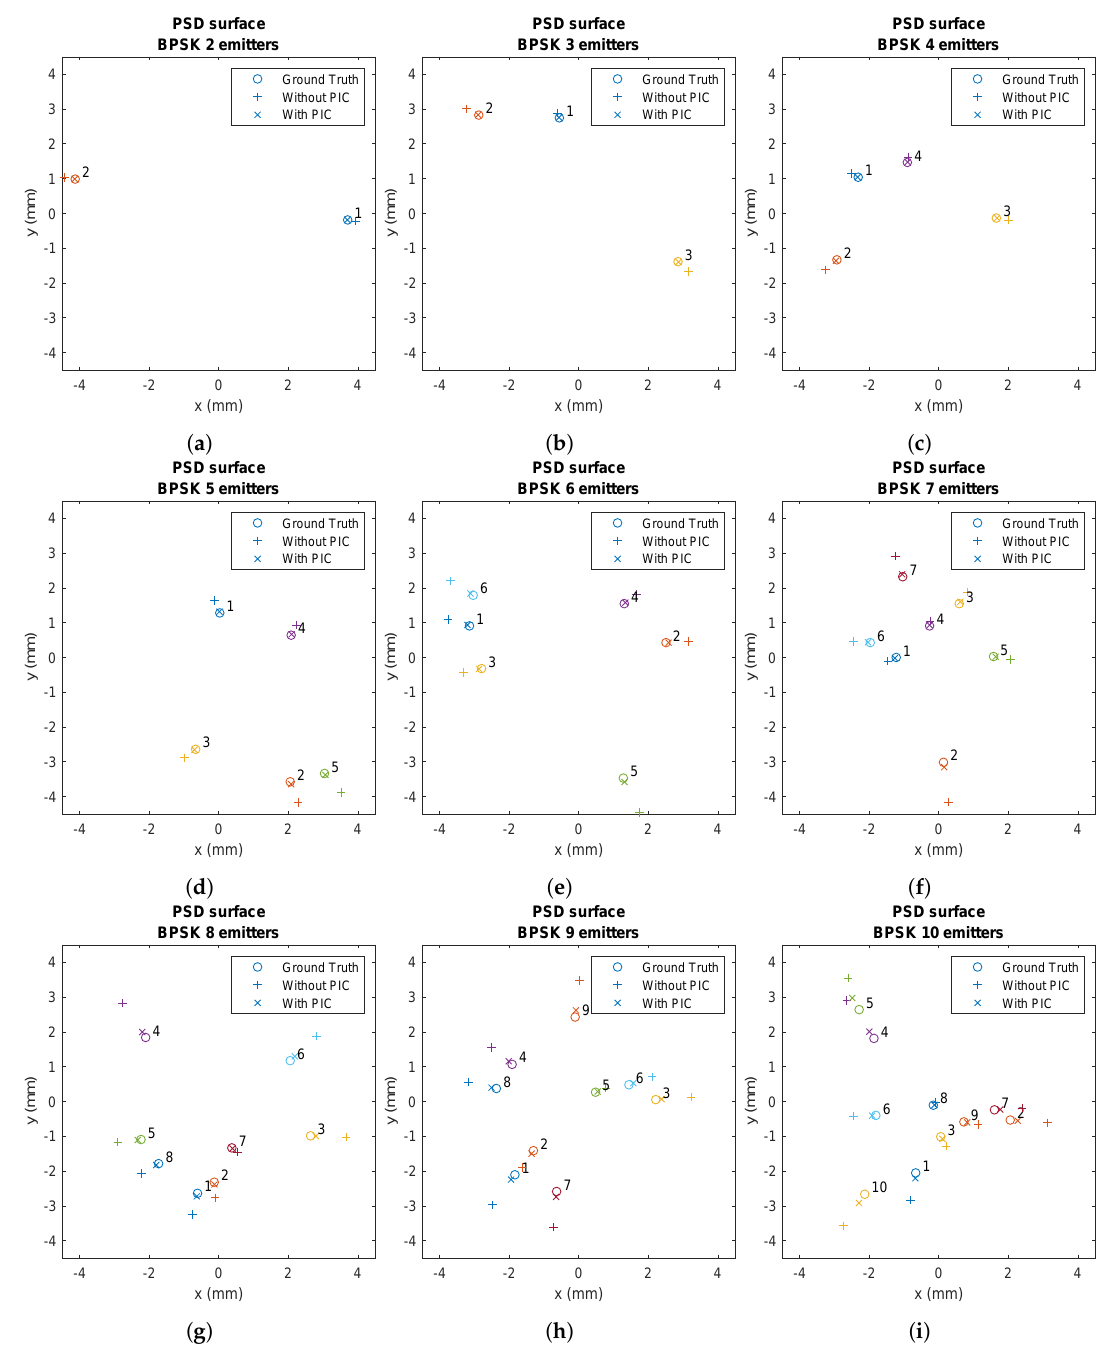
Figure 17. Impact points in the PSD using CDMA-BPSK with 10 bit size before and after applying correction with: ( a ) two emitters; ( b ) three emitters; ( c ) four emitters; ( d ) five emitters; ( e ) six emitters; ( f ) seven emitters; ( g ) eight emitters; ( h ) nine emitters; and ( i ) ten